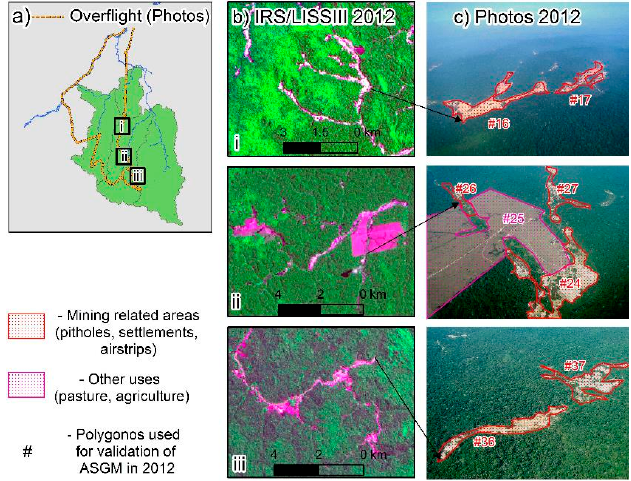
Figure 5. ( a ) An overflight was taken in the study area to identify ASGM and validate classification of land use based on IRS/LISSIII images (R/G/B: Red/NIR/Green bands) ( b ). Examples of eight polygons extracted from three different areas ( i – iii ) includes mining-related areas ( in red ) and other land uses that are not associated with mining ( in purple ). The visual identification of the polygons in the photos considered the spatial distortion caused by the oblique view of the camera used. ( c ) photos taken in 2012.